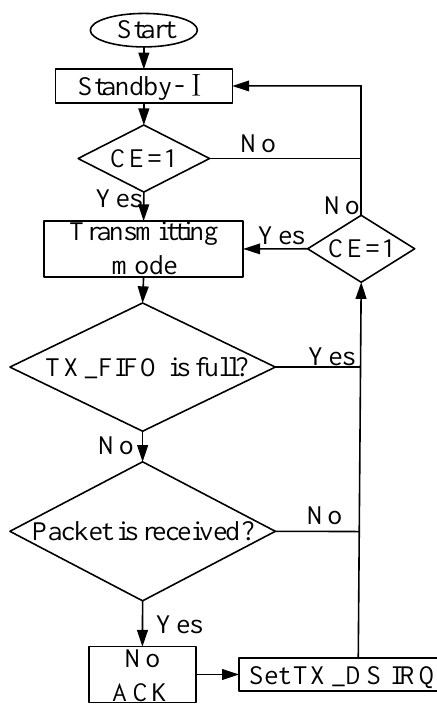
Figure 9. The nRF24L01 data reception